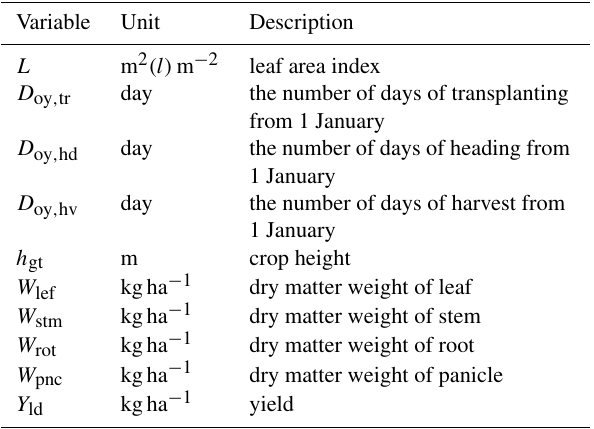
Table 3. Observational data used for